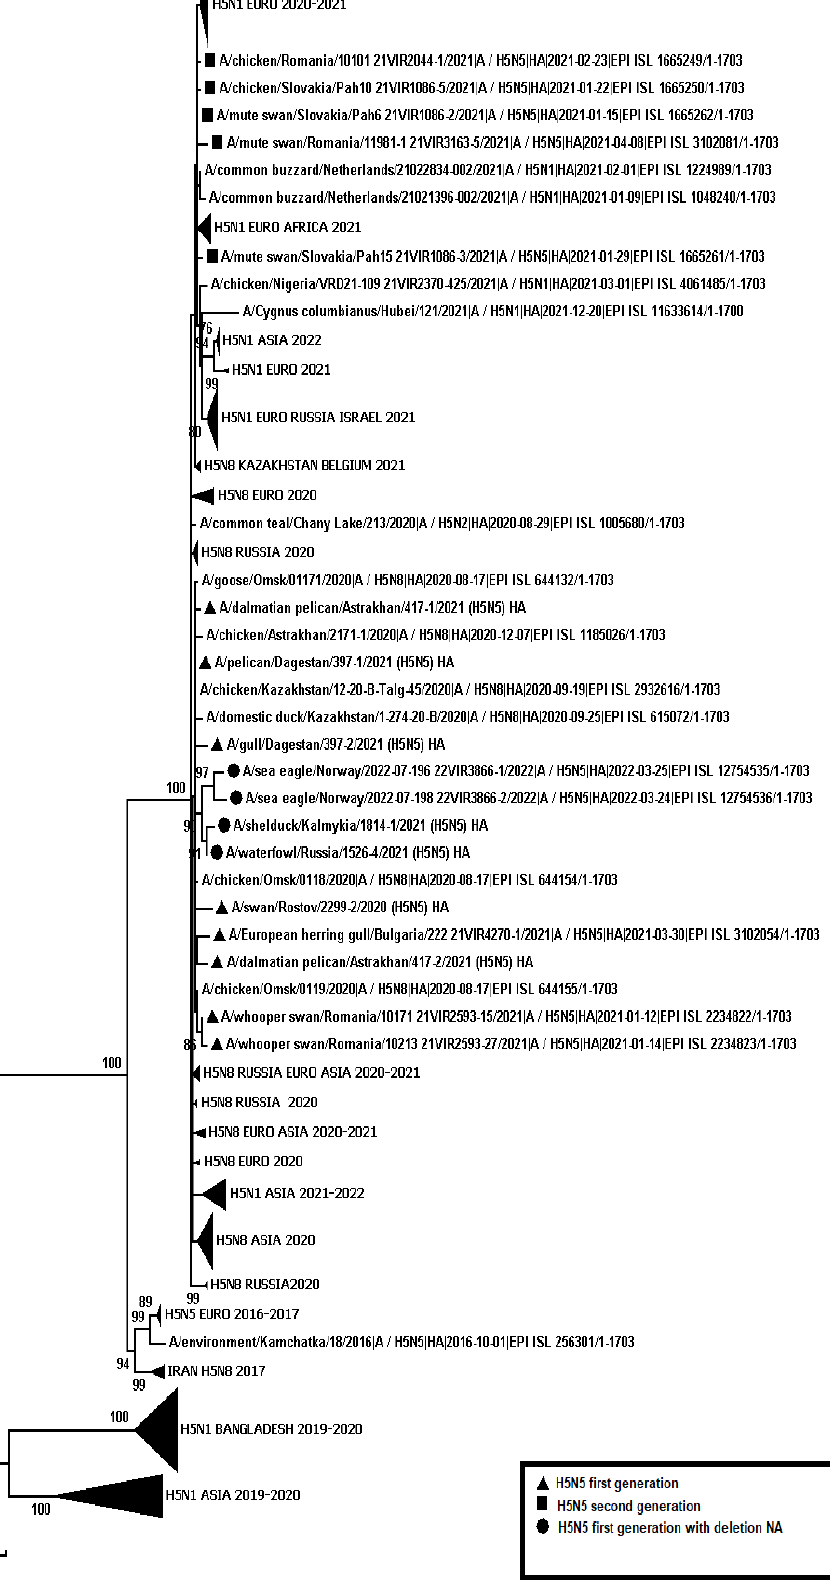
Figure 1. Phylogenetic tree constructed using the Neighbor Join (NJ) method, based on the nucleotide sequence of the HA gene fragment (1–1704 b.p. ORF) of the AIV subtype.